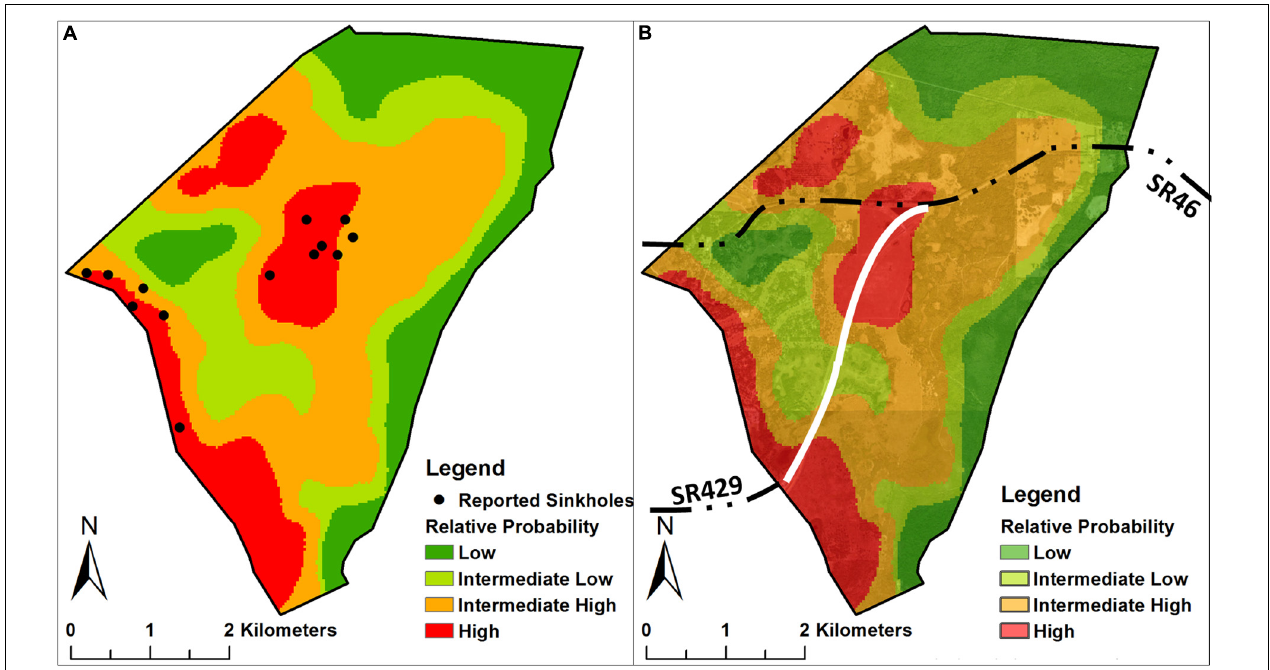
FIGURE 4 | (A) Spatial variation of the relative probability of sinkhole development and locations of reported sinkholes; (B) relative probability of sinkhole development at the under-construction expressway (see the solid white line) and its